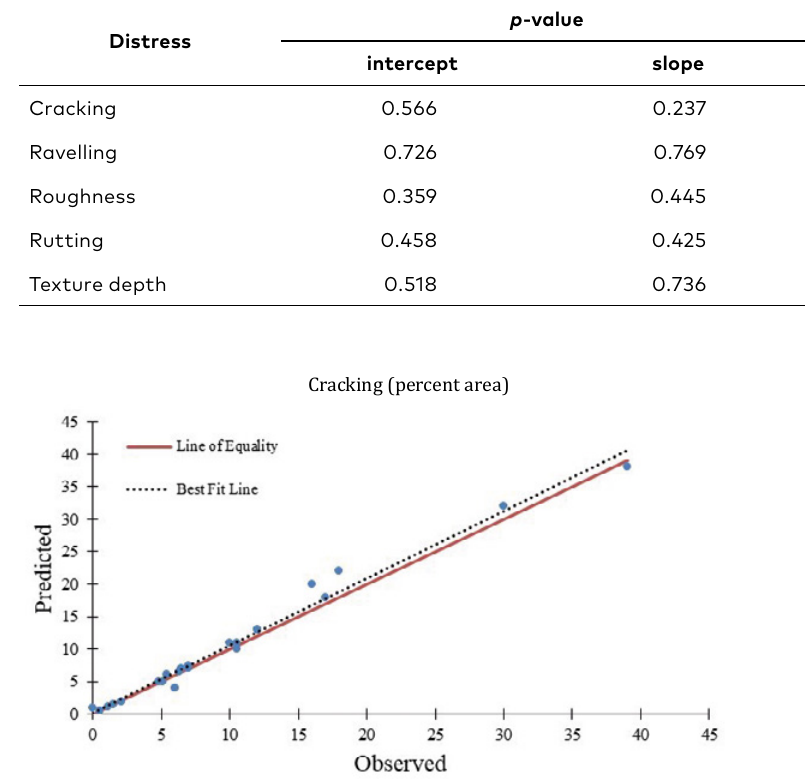
Table 3. Results of validation